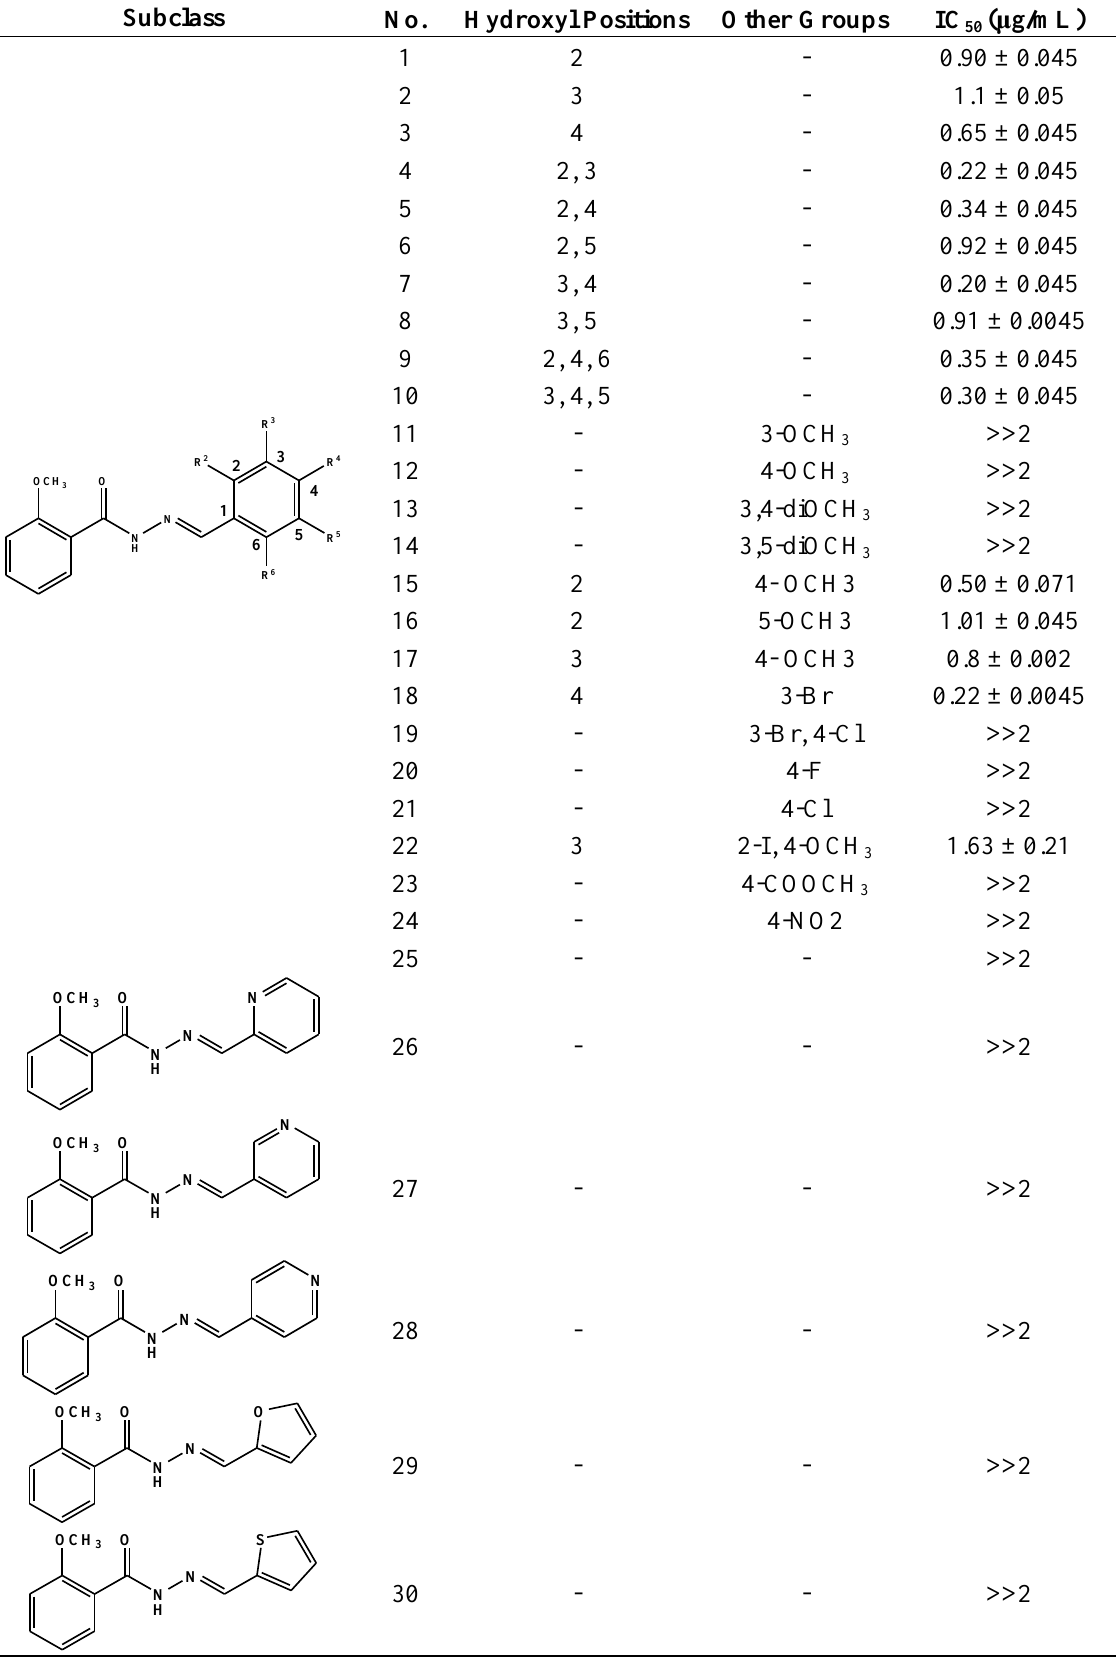
Table 1. Molecular structures of the synthesized Schiff bases and their antioxidant